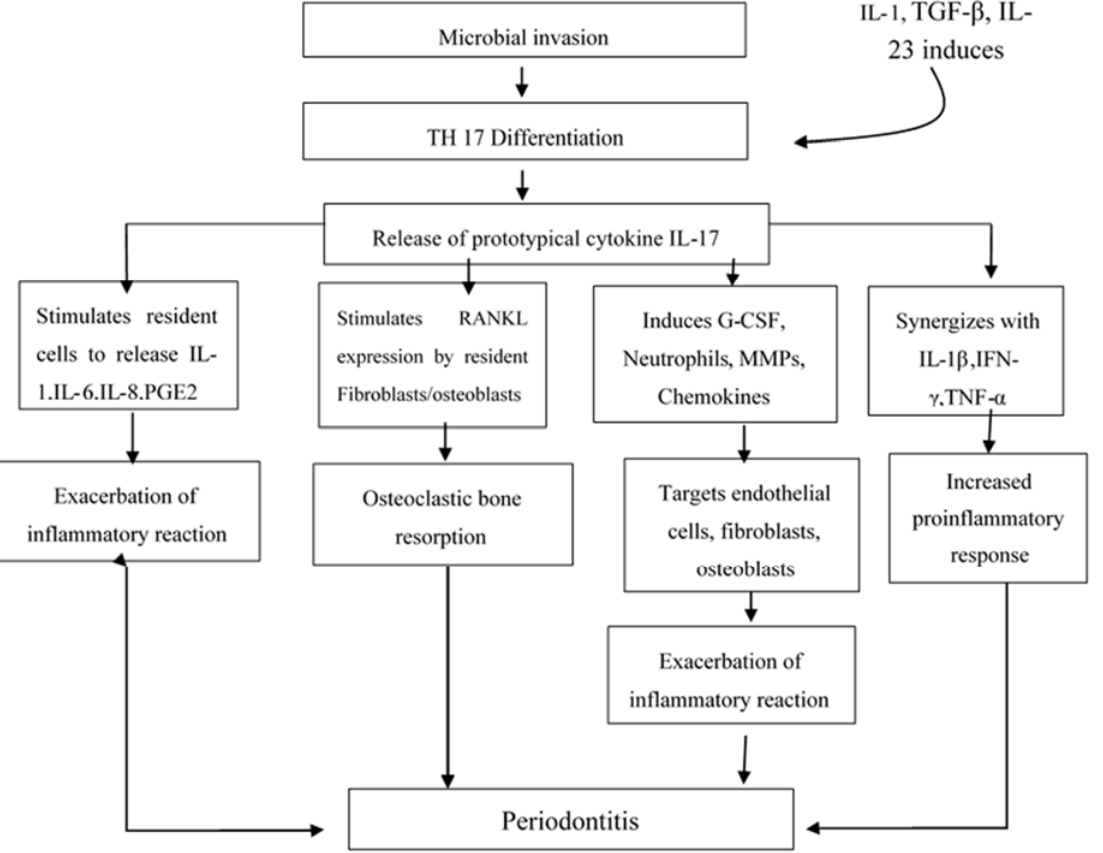
Figure 1. Role of IL-17 in the pathogenesis of periodontitis.